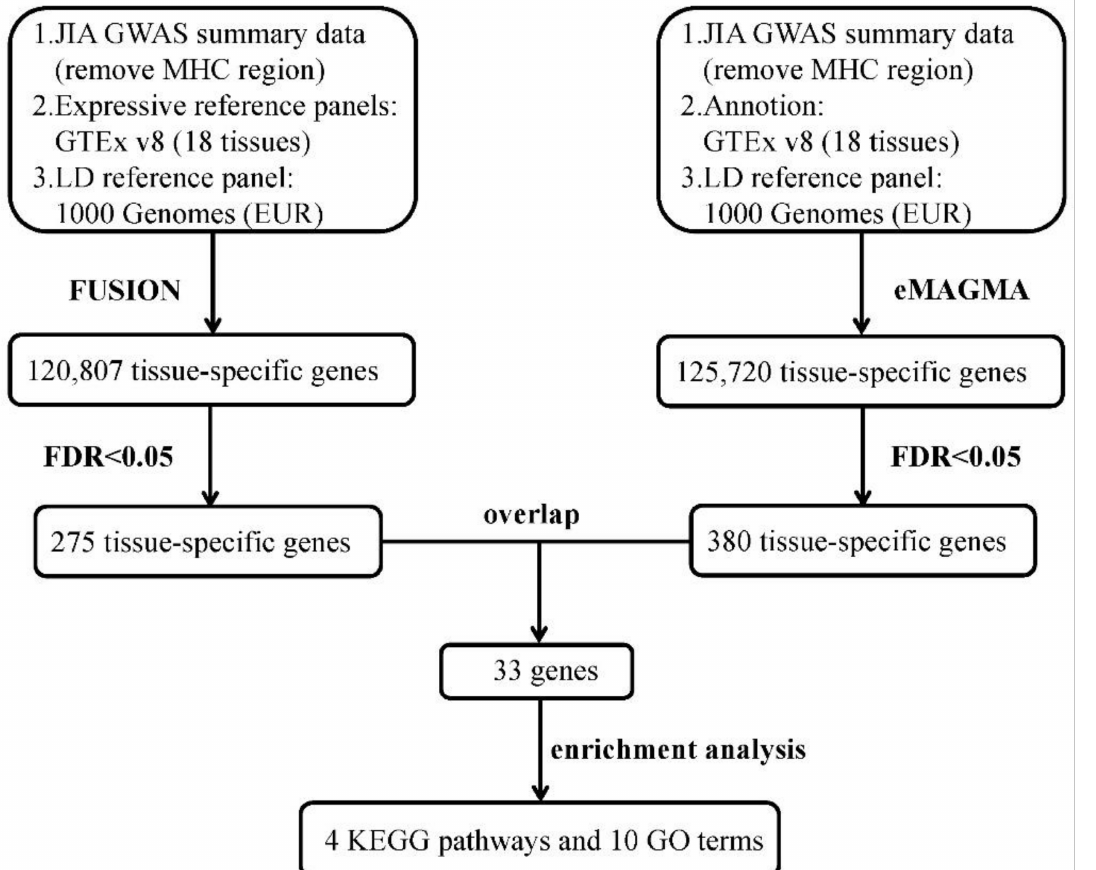
Figure 1. The flowchart of integrative analysis of FUSION and eMAGMA. ABBR: JIA, Juvenile idiopathic arthritis; GWAS, genome-wide association study; MHC, major histocompatibility complex; GTEx, Genotype-Tissue Expression Project; LD, linkage disequilibrium; EUR, European; FUSION, functional summary-based imputation; eQTL, expression quantitative trait loci; eMAGMA, eQTL Multi-marker Analysis of GenoMic Annotation; FDR, false discovery rate; KEGG, Kyoto Encyclopedia of Genes and Genomes; GO, Gene